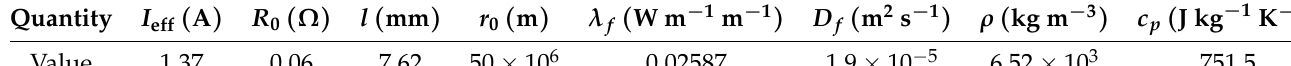
Table 1. Thermal and electrical values used for the analytical calculations using Equation (6). The electrical parameters I eff and R were taken from the simulation, and the thermal quantities ρ and c p were calculated proportionally for tungsten and air using literature values.